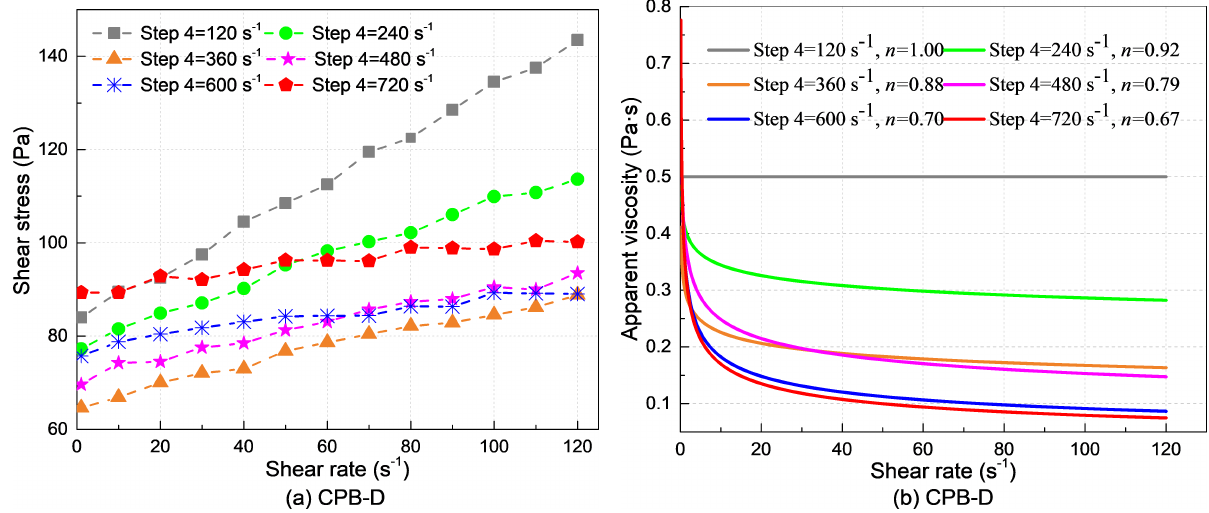
Figure 9: Effect of shear on flow curve behavior of